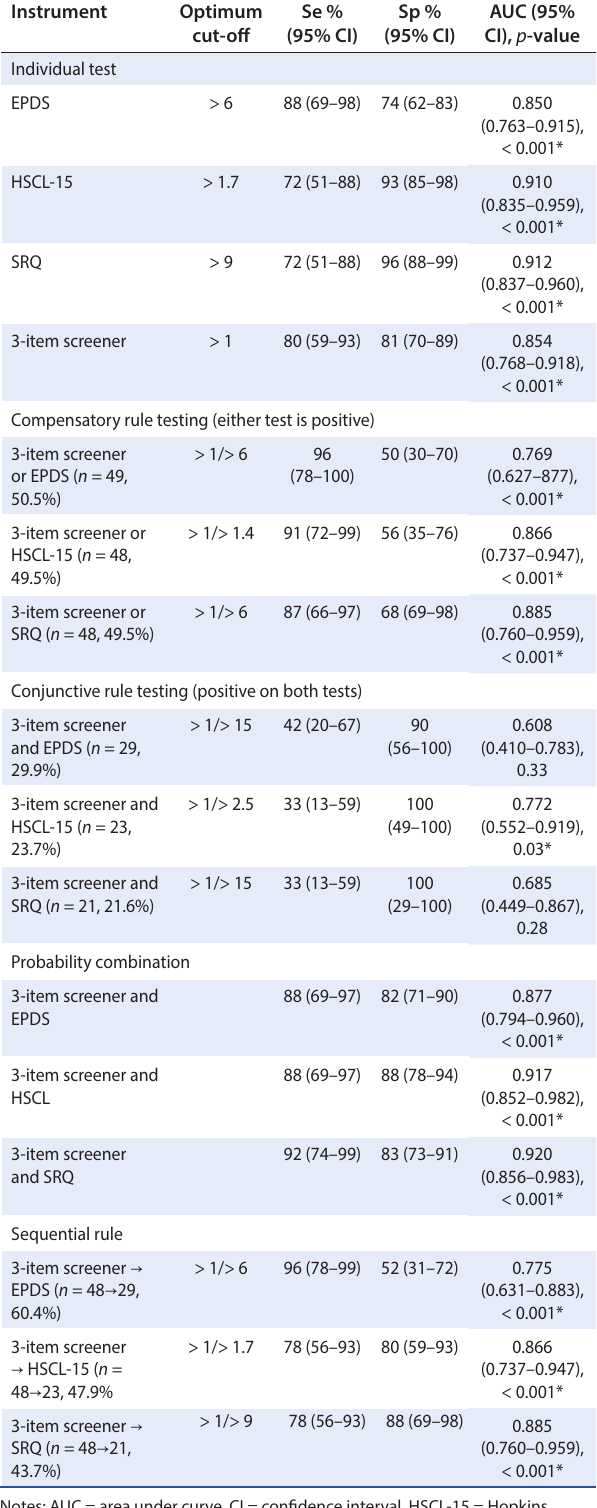
Table 3: Performance of individual instruments and various combinations of screening